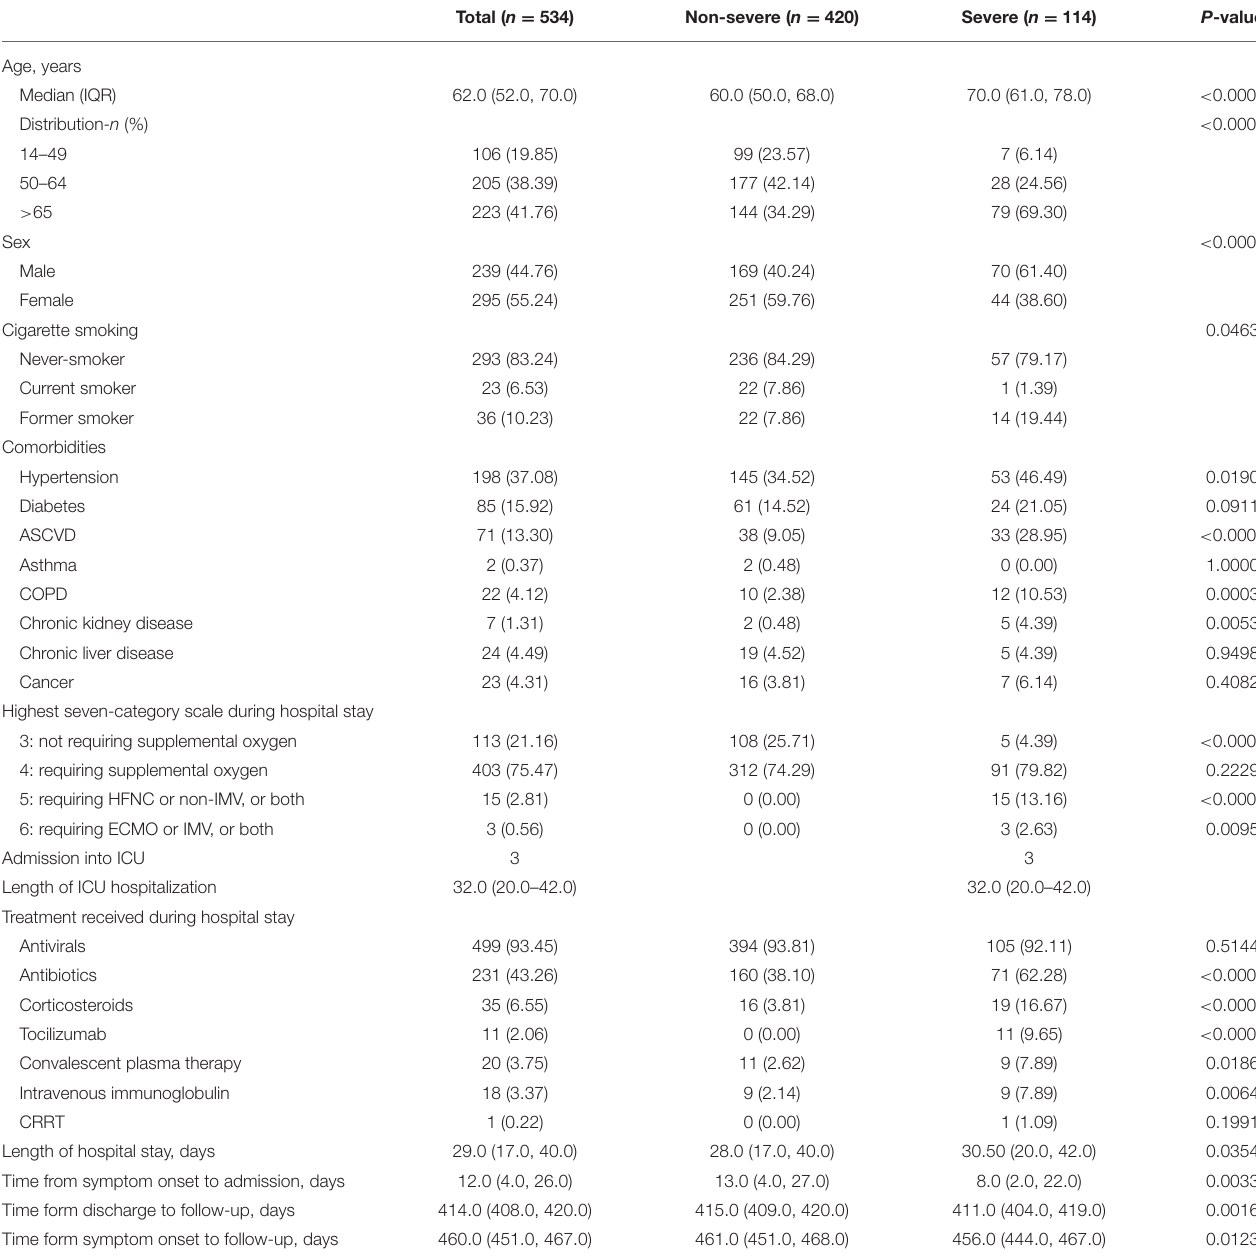
TABLE 1 | Characteristics of 534 enrolled patients with